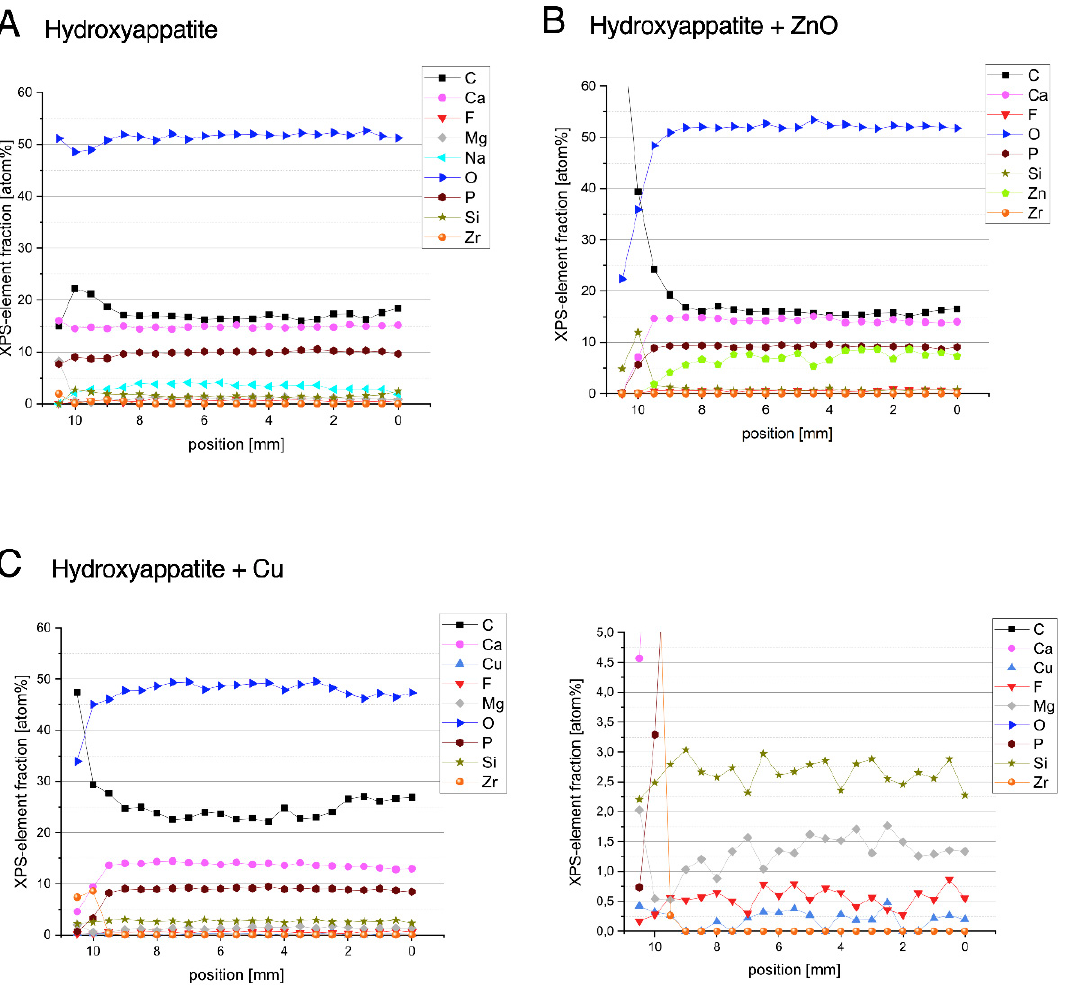
Figure 1. XPS analyses show the chemical composition of specimens after coating with hydroxyapatite ( A ) and hydroxyapatite with zinc ( B ) or copper ( C ). On the right side, an additional extract is shown for better visualization of the amount of copper.